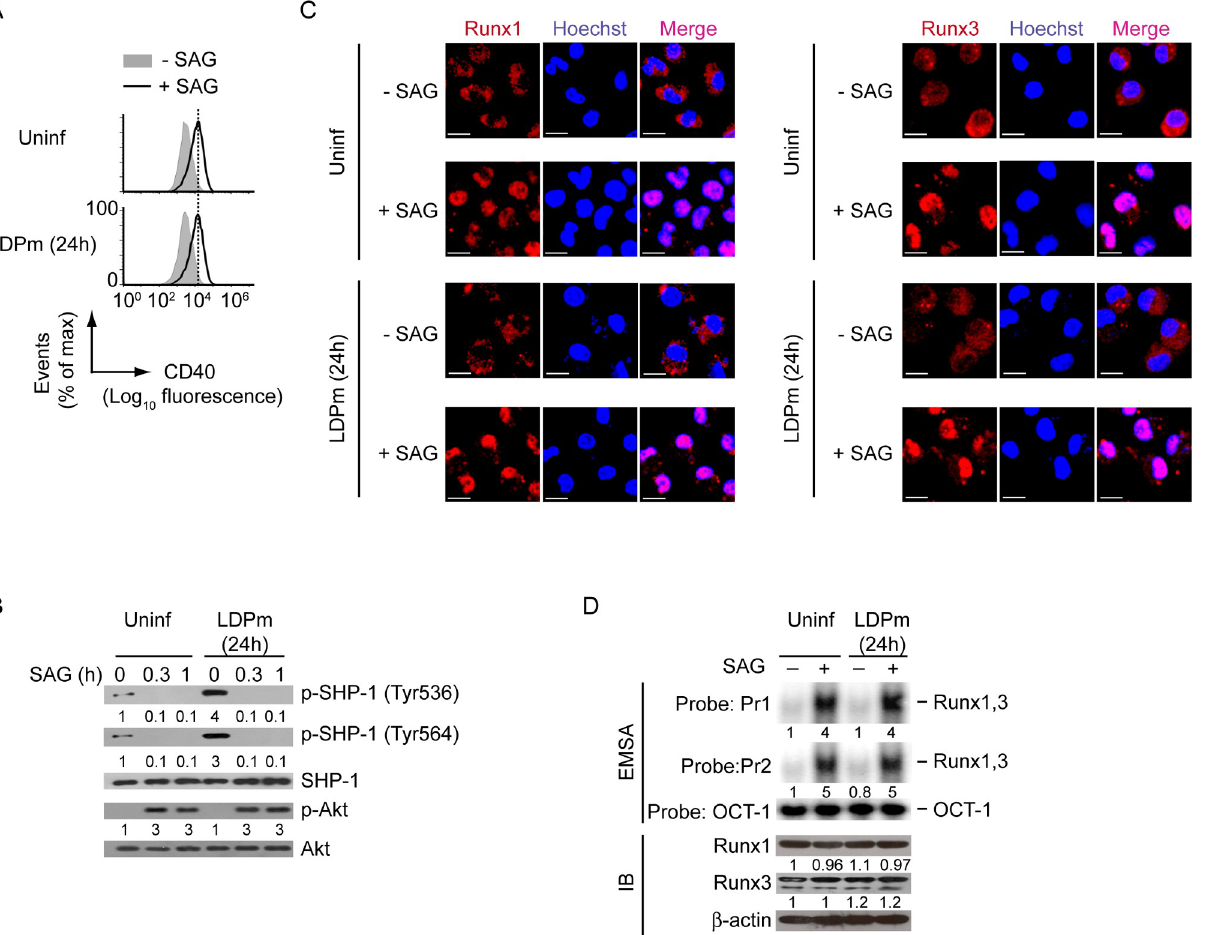
Fig 8. SAG-mediated SHP-1 inhibition allows PI3K-Akt-Runx signaling to upregulate CD40 expression on LD-infected DCs. (A) CD40 expression profile on BMDCs left uninfected or infected with LDPm for 24 h, then treated with or without SAG for 24 h, assessed by flow cytometry. Data are representative of three independent experiments. (B) Immunoblot analysis of total and phosphorylated SHP-1 and Akt in lysates of BMDCs infected with LDPm for 24 h or left uninfected and then treated with SAG for indicated times. Number below lanes indicate densitometry of phosphorylated SHP-1 (normalized to total SHP-1) or phosphorylated Akt (normalized to total Akt), presented relative to uninfected BMDCs treated with SAG for 0 h. Data are representative of three independent experiments. (C) Confocal microscopy of the translocation of Runx1 or Runx3 (red) into the nuclei (blue; Hoechst staining) in BMDCs left uninfected or infected with LDPm for 24 h, then cultured with or without SAG for 0.5 h. Pink color (merge) shows nuclear translocation of Runx1 or Runx3. Scale bar, 10 μ m. Data are representative of two independent experiments. (D) EMSA (with probes as in Fig 2) assessing the binding of nuclear Runx1 and Runx3 to the CD40 promoter (upper panel) and immunoblot analysis depicting Runx1 and Runx3 expression (lower panel) in BMDCs left uninfected or infected with LDPm for 24 h, then cultured for 0.5 h with or without SAG. Numbers below lanes indicate densitometry quantification of Runx1 and Runx3 binding to the CD40 promoter (EMSA panels; normalized to OCT-1 binding), and the levels of Runx1 and Runx3 proteins [immunoblot (IB) analysis panels; normalized to β -actin]; presented relative to uninfected BMDCs cultured without SAG. Data are representative of three independent experiments. For all experiments LD strain AG83 was used. The relative MFI of CD40 expression for (A) and the densitometry results for (D) pooled from three independent experiments are shown in S15 Fig.